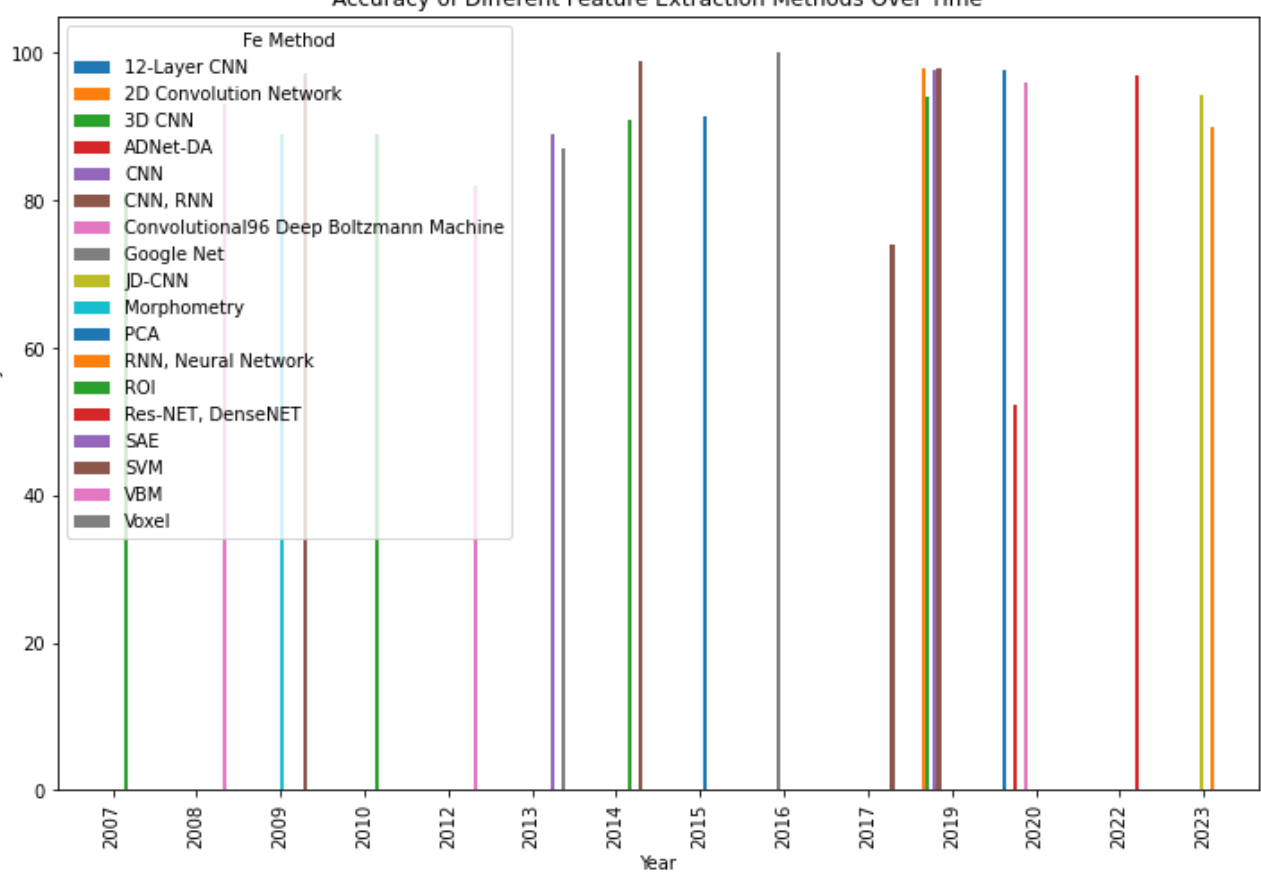
Figure 10. Feature Extraction Methods, year wise analysis.